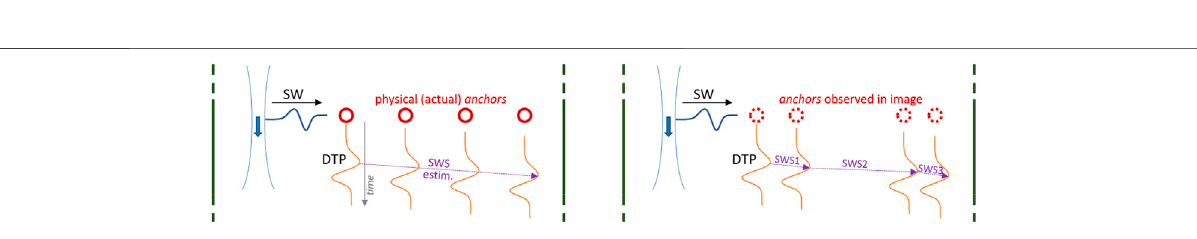
Frontiers in Physics |